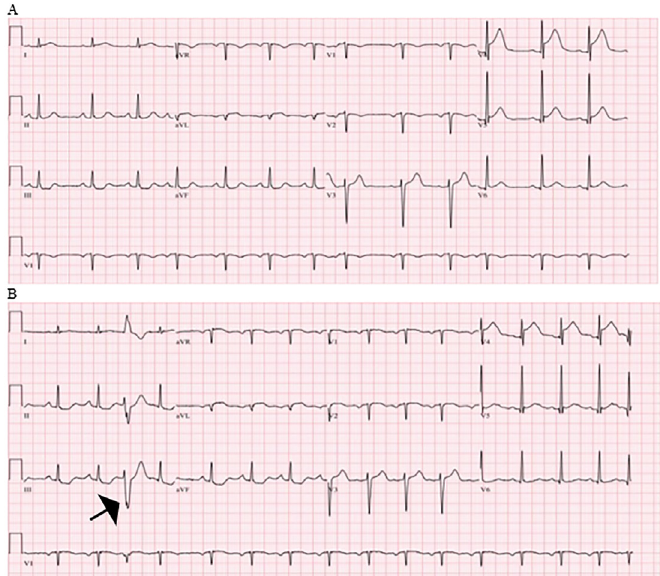
Image 2. Initial (A) and repeat (B) electrocardiogram of a 73-year- old female with syncope and subsequent motor vehicle